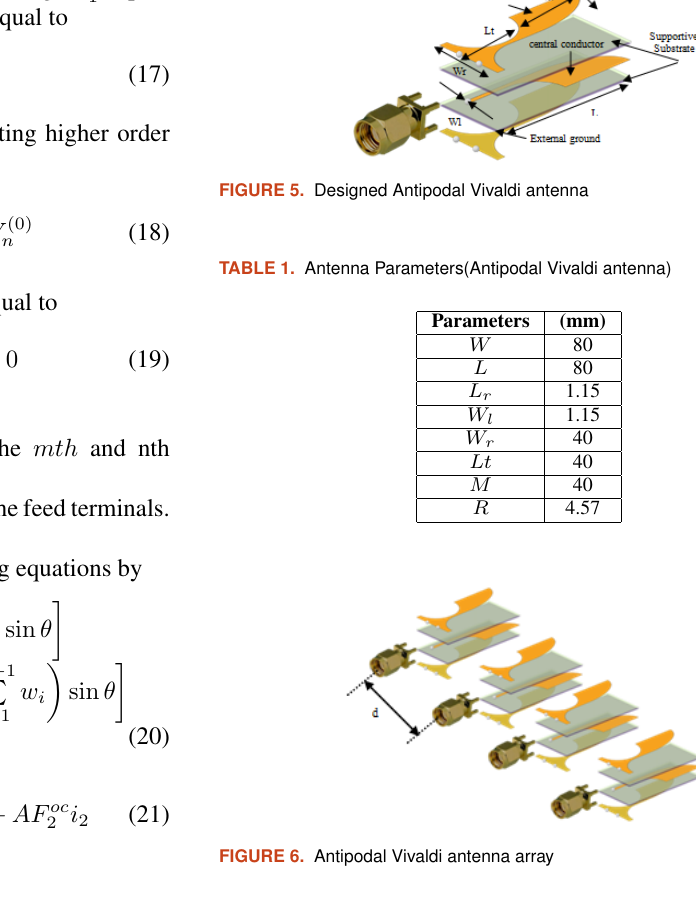
FIGURE 6. Antipodal Vivaldi antenna